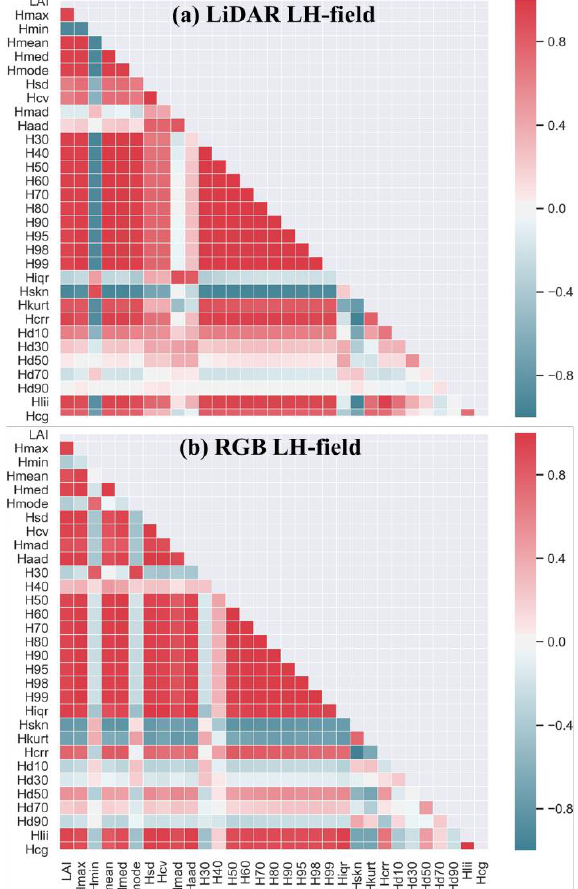
Figure 8. Correlation coefficient between point cloud-derived canopy structure metrics and leaf area index (LAI). LiDAR- based metrics for LH-field (a); RGB photogrammetry-based metrics for